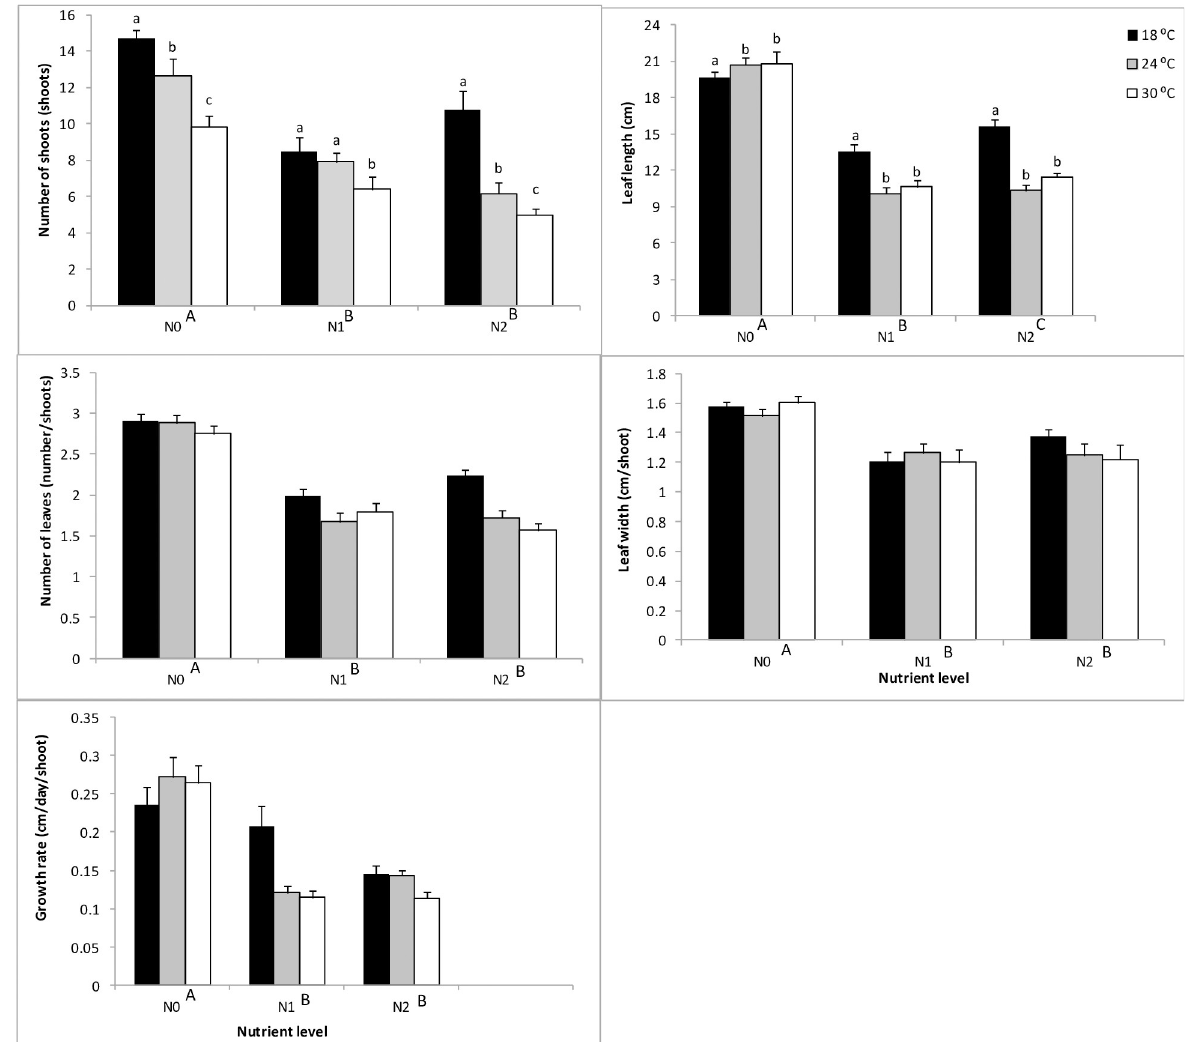
Fig 1. Main and interactive effects of temperature and nutrient treatments on A: shoot number; B: number of leaves; C: leaf length; D: leaf width and E: growth rate. Values are mean ± SE, n = 3. Different letters above bars denote differences between temperature levels within nutrient treatments. Different capital letters adjacent to nutrient levels denote differences among nutrient